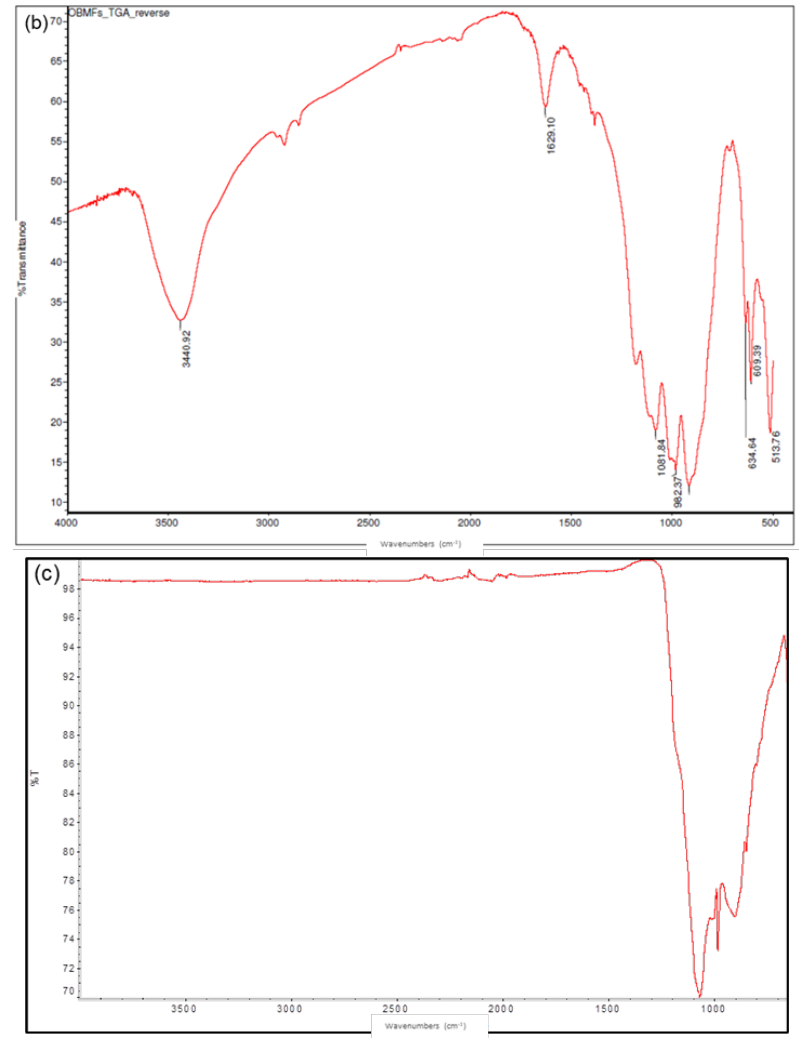
Figure 5. ATR-FTIR full scale spectra of ( a ) OBM waste slurry; ( b ) OBM waste residue after TGA analysis and ( c ) OBM waste dry powder.